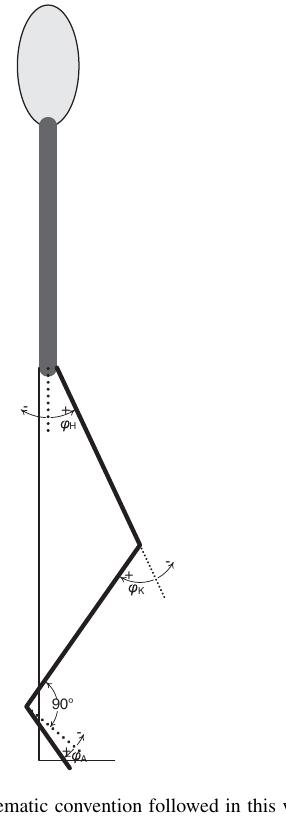
Fig. 4. The joint kinematic convention followed in this work. ϕ H , ϕ ϕ K and A are hip-, knee- and ankle-angle